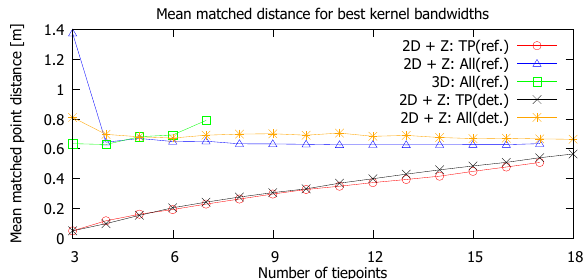
Figure 9: Results of kernel bandwidth grid search for real data - mean matched point distance curves by tiepoint count for manual reference (ref.) and automatically detected (det.) positions